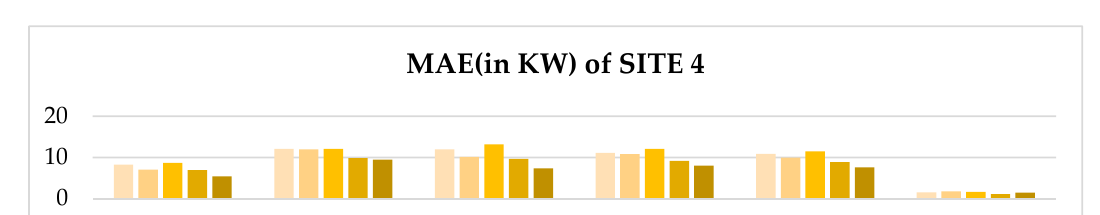
Electronics 2020 , 9 , x FOR PEER REVIEW Figure 15. Comparative MAE (in KW) results of SITE 3A. Figure 15. Comparative MAE (in KW) results of SITE 3A. Figure 15. Comparative MAE (in KW) results of SITE 3A.